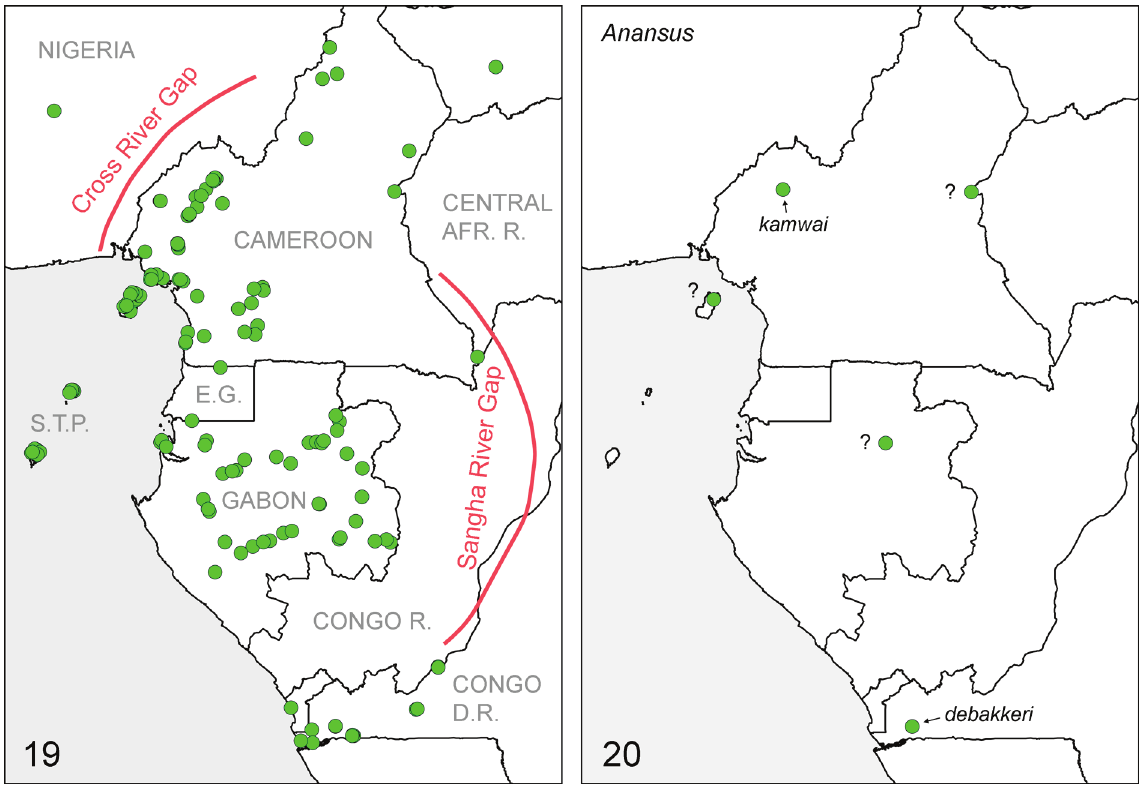
Figs 19-20. All pholcid records known from Central Africa (19) and known distribution of the genus Anansus Huber, 2007 in Central Africa (20). Question marks denote uncertain identifications (females from Bioko and Gabon and one poorly preserved male from eastern Cameroon). E.G. = Equatorial Guinea; S.T.P. = São Tomé and